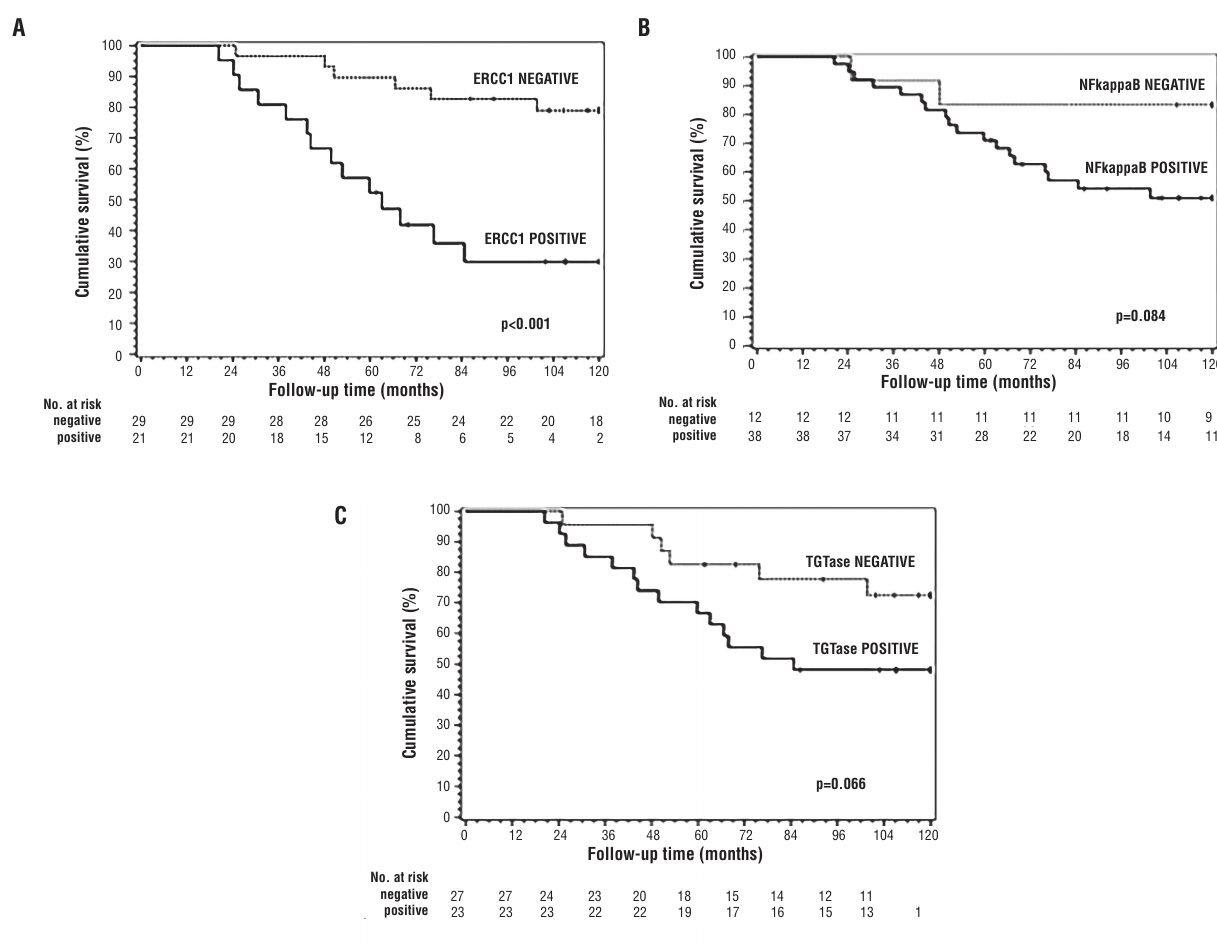
Figure 3 - Kaplan-Meier estimate of overall survival probability according to ERCC1, p <0.001. A) NF- κ B, p=0.084; B) and TG2, p=0.066; C). The differences in OS between categories of interest were analyzed using the log-rank test, and the significance level was set at α